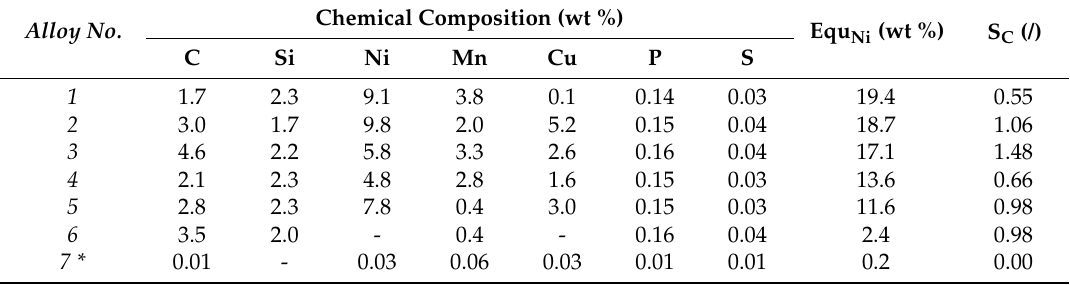
Table 1. Chemical compositions, nickel equivalent Equ Ni and eutectic saturation ratio S C [17]. Alloy